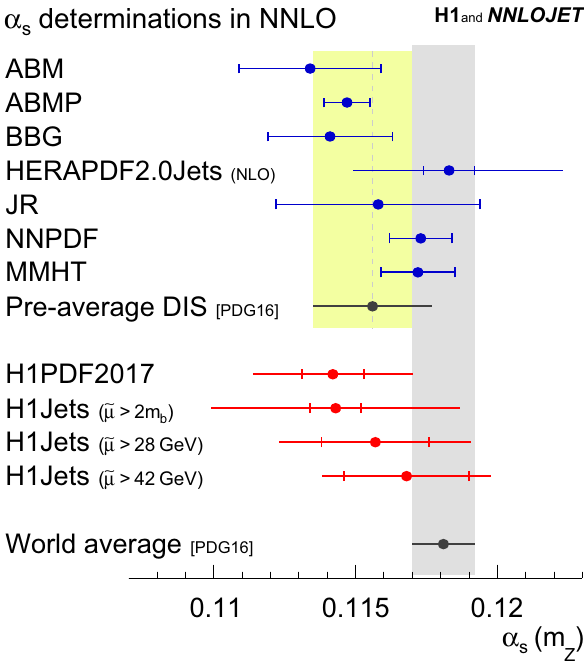
Fig. 15 Comparison of the value of α s ( m Z ) obtained in the H1PDF2017 [NNLO] PDF+ α s -fitandintheH1jetsfitinNNLOaccuracy to other α s determinations from DIS data. The pre-average of structure function data and the world average [2] are also indicated